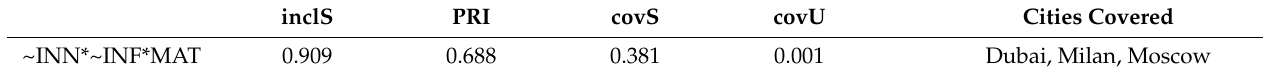
(Table 4). The solution consists of five conjunctions with acceptable parameters: ~INN*